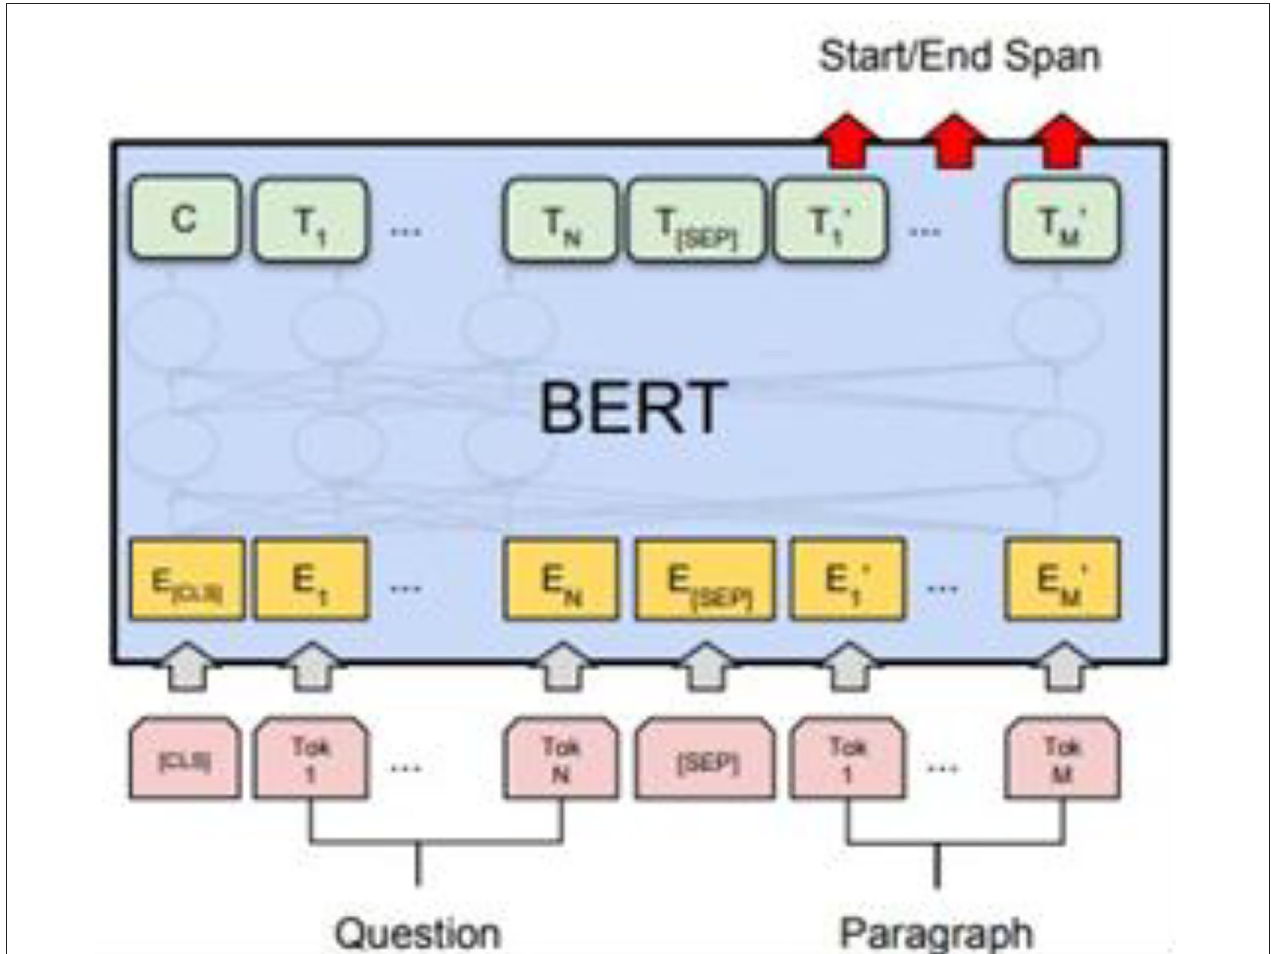
FIGURE 10 | The Bert language